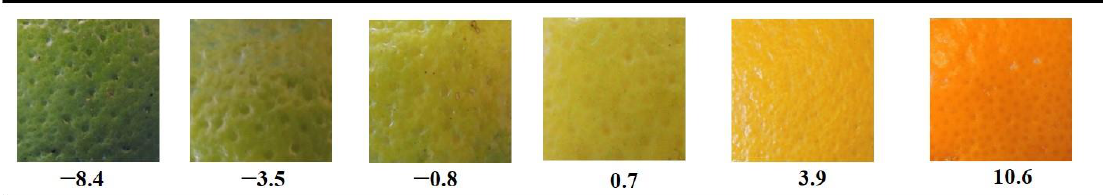
Figure 1. Representation of the development of the citrus color index (CCI) of ‘Valencia’ orange fruits when trees are grafted on different ‘Trifoliata’ hybrid rootstocks in different stages of ripening.